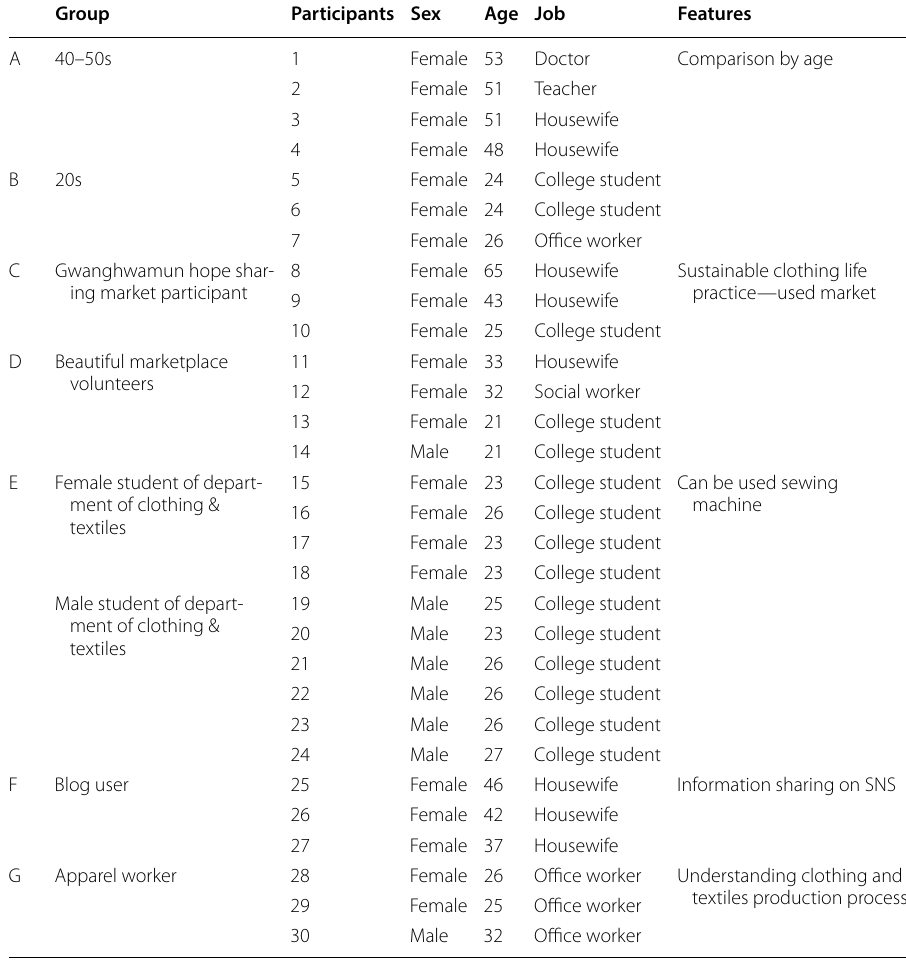
Table 1 Focus group interview participants